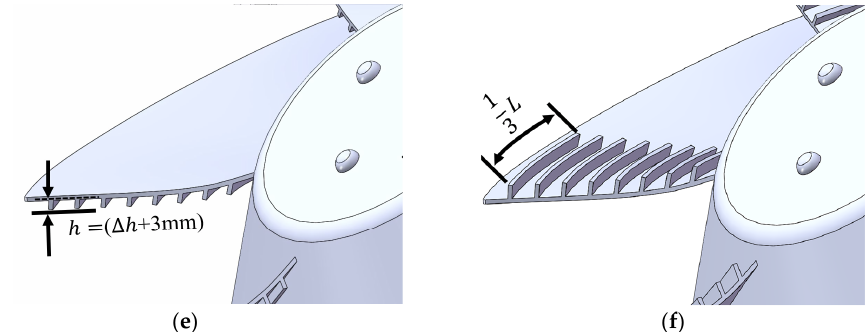
Figure 2. Basic and biomimetic blade designs, groove number N = 9: ( a ) Whole basic impeller, ( b ) Basic shape, ( c ) Wavy shape, ( d ) Riblet shape_ Suction face, ( e ) Riblet shape_ Pressure face, and ( f ) Riblet shape_ Suction face_L1/3. The rectangle region in ( a ) is exaggerated as in other figures. The lozenge region in ( b ) is the leading-edge region.